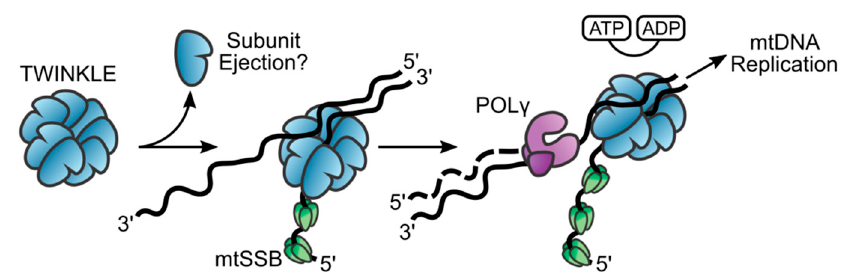
Figure 3. Helicase activity of TWINKLE. TWINKLE is the sole replicative helicase in mitochondria. It is proposed that heptameric TWINKLE ejects a subunit upon binding to ssDNA and performs ATP-dependent 5 ʹ –3 ʹ unwinding of DNA. This enables POLRMT to synthesize RNA primers on which POL γ can extend, allowing for leading-strand replication. The displaced ssDNA is coated by mtSSB until it is displaced by the lagging-strand replication machinery.